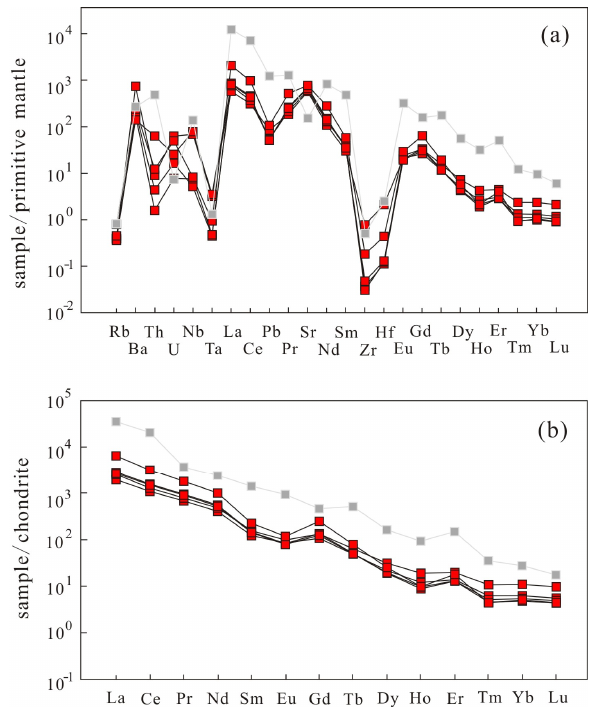
Figure 6. Primitive-mantle-normalized trace element ( a ) and chondrite-normalized REE patterns ( b ) for rock samples from the Dol-dyke. The gray lines are data of ore-hosting dolomites from the Bayan Obo deposit [26]. Data for normalisation according to [39].